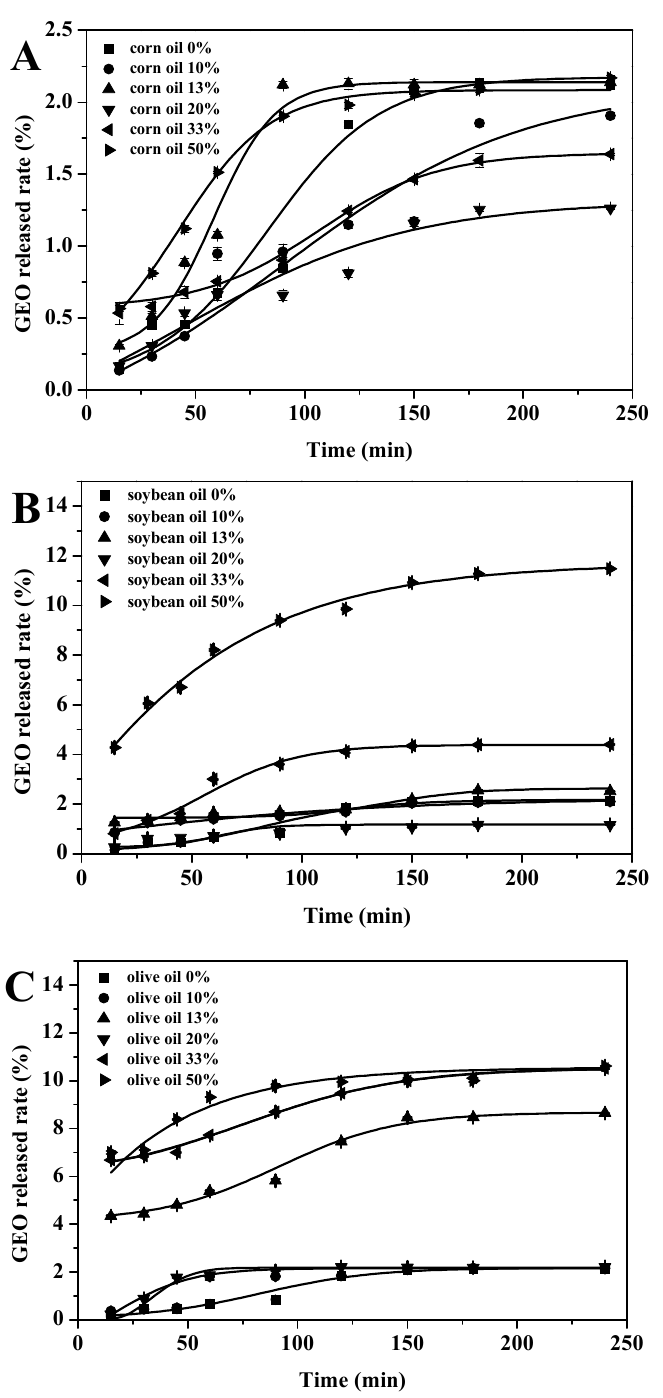
Figure 3. GEO released curves of microcapsules prepared with different concentrations of CO ( A ), SO ( B ) and OO ( C ).